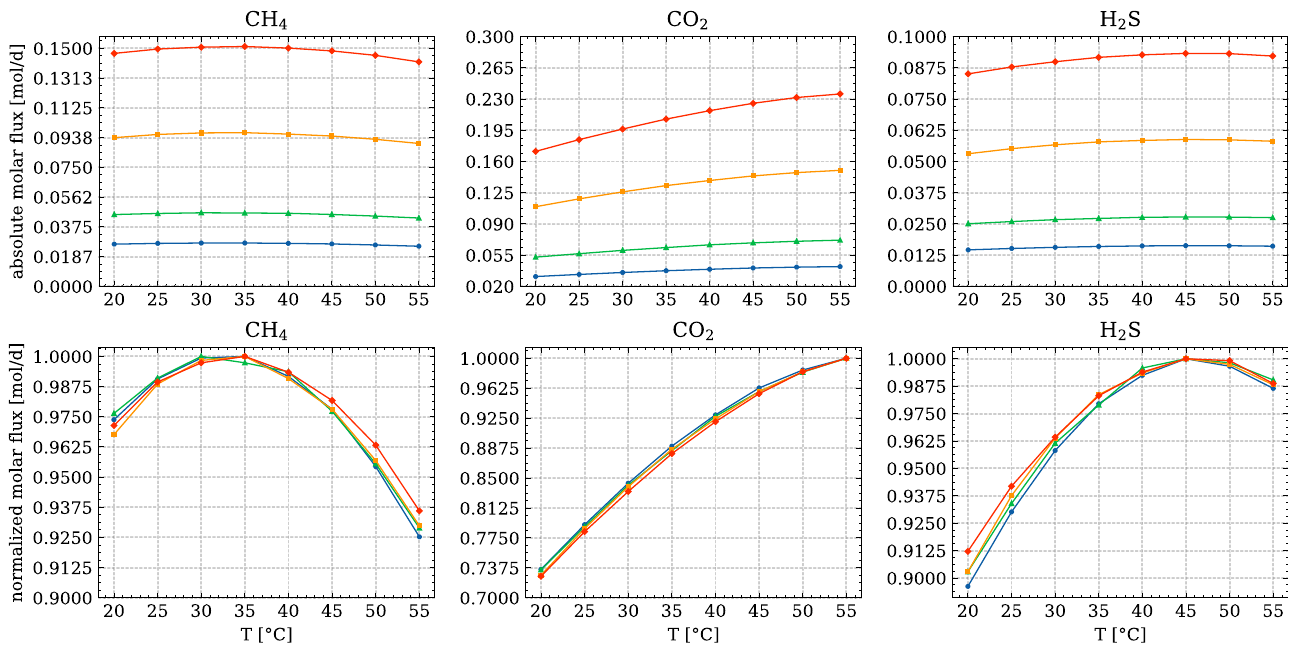
Figure 7. Absolute and normalised molar fluxes of the light-key species at different pressure and temperatures;